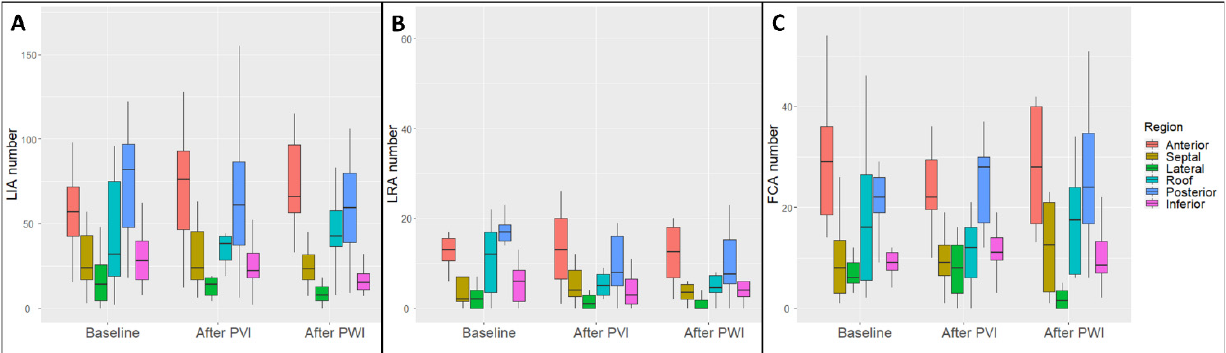
Figure 4. Regional analysis of abnormal activation patterns in charge density mapping. Each color box in the graph corresponds to the color-matched region (legend on the right). ( Panel A ) LIA absolute number by region and procedural step, namely, baseline, after pulmonary vein isolation (PVI) and after left atrial posterior wall isolation (LAPWI). ( Panel B ) LRA absolute number by region and procedural step, namely, baseline, after PVI and after LAPWI. ( Panel C ) FCA absolute number by region and procedural step, namely, baseline, after pulmonary vein isolation (PVI) and after LAPWI. FCA: focal centrifugal activation; LIA: localized irregular activation; LRA: localized rotational activation. The midline of each boxplot is the median, with the upper and lower limits of the box being the 3rd and 1st quartiles (75th and 25th percentiles), respectively. By default, the whiskers will extend up to 1.5 times the interquartile range from the top (bottom) of the box to the furthest datum within that distance.